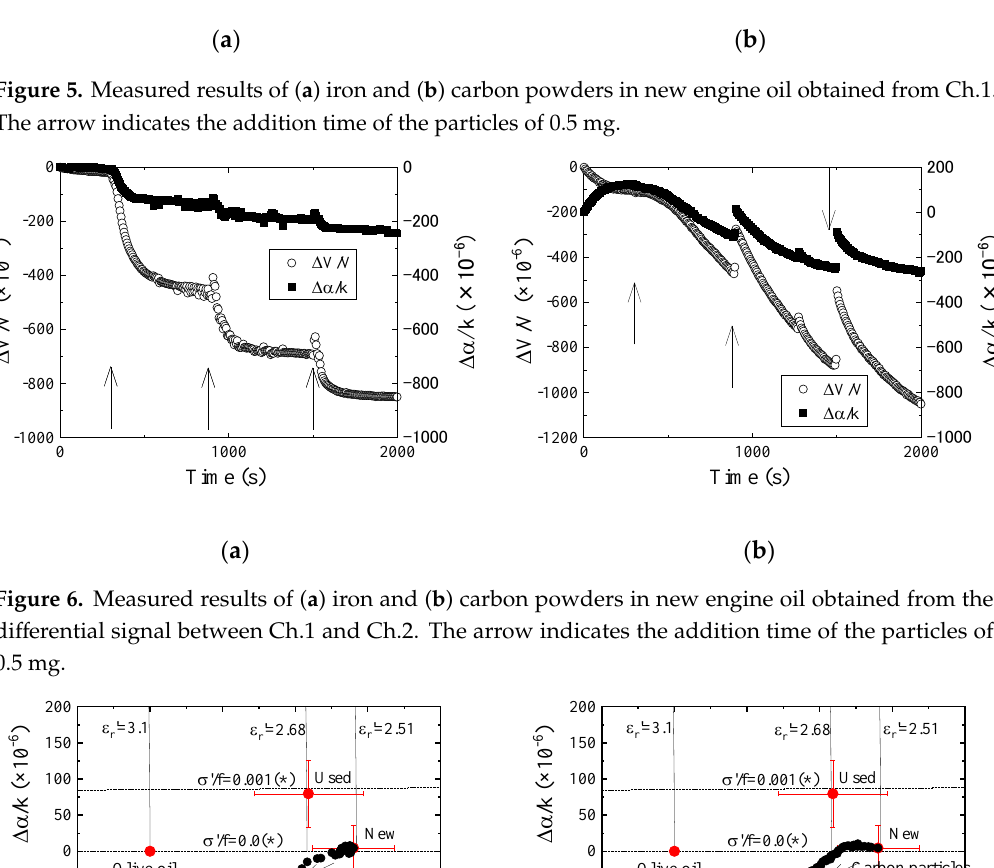
Figure 6. Measured results of ( a ) iron and ( b ) carbon powders in new engine oil obtained from the differential signal between Ch. 1 and Ch. 2. The arrow indicates the addition time of the particles of 0.5 mg.